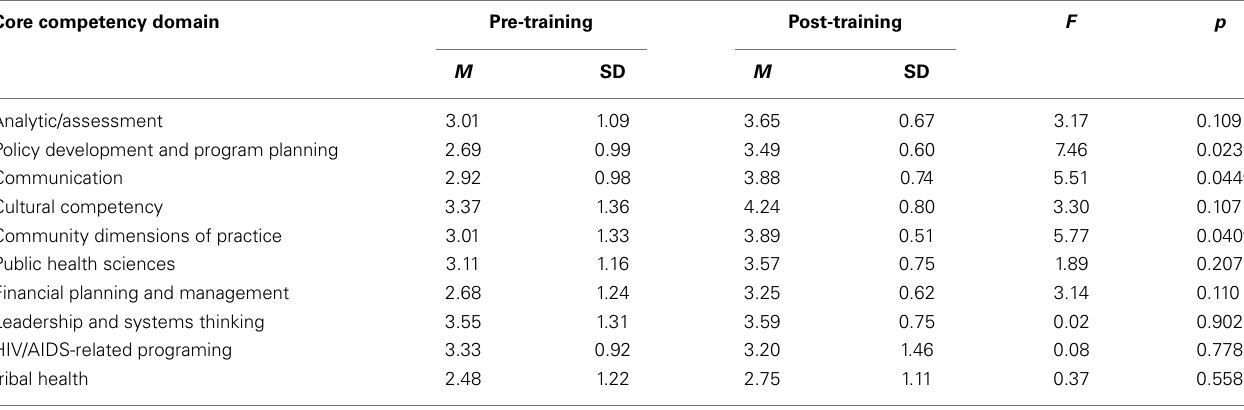
Table 3 | Comparison of public health core competency skills before and after the training experience